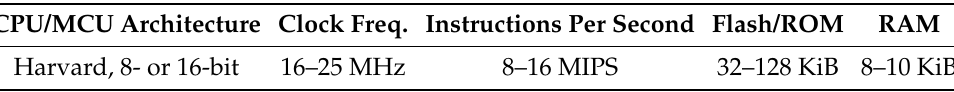
Table 1. Typical amount of resources for target WSN